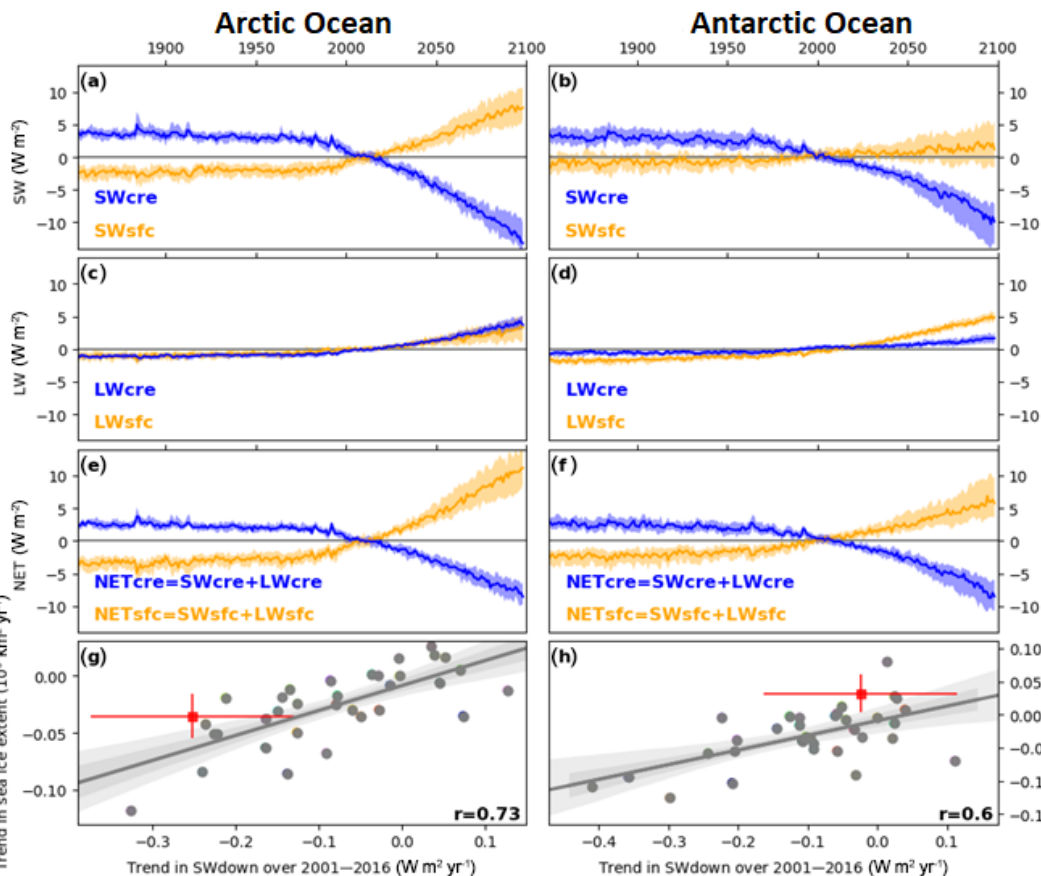
Figure 9. Time series of the anomaly with respect to the whole period 1850–2100 of the radiative flux. Mean modelled SW cre , LW cre and NET cre (blue) and surface SW sfc , LW sfc and NET sfc (orange) anomalies over the 1850–2100 period under the RCP8.5 scenario averaged over the Arctic Ocean. The solid line shows the median, where the envelope represents the 25th and 75th percentile of the 32 CMIP5 models. The linear regression (grey solid line and its 68% – dark-grey envelope – and 95% – light-grey envelope – confidence interval) between the trend in SW down and trend in sea ice extent (g, h) of the 32 CMIP5 climate models shown by grey dots over 2001–2016. The observed trends are shown by red colours, where the confidence interval refers to the standard error of the